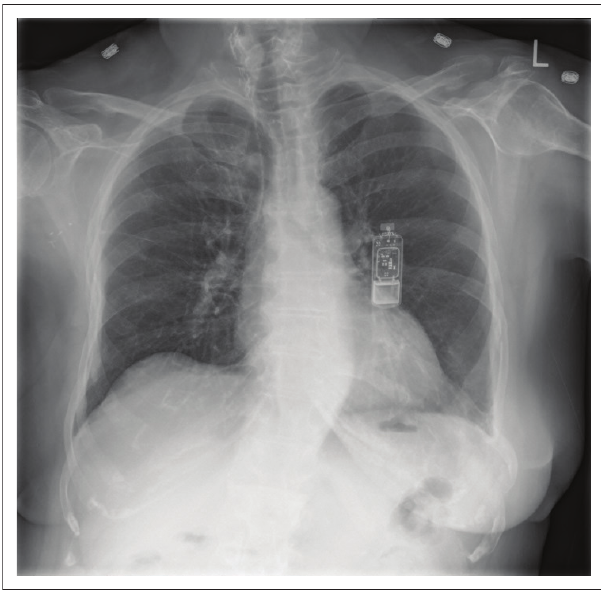
FIGURE 12: Chest radiograph of a 67-year-old female patient with an implantable loop recorder.